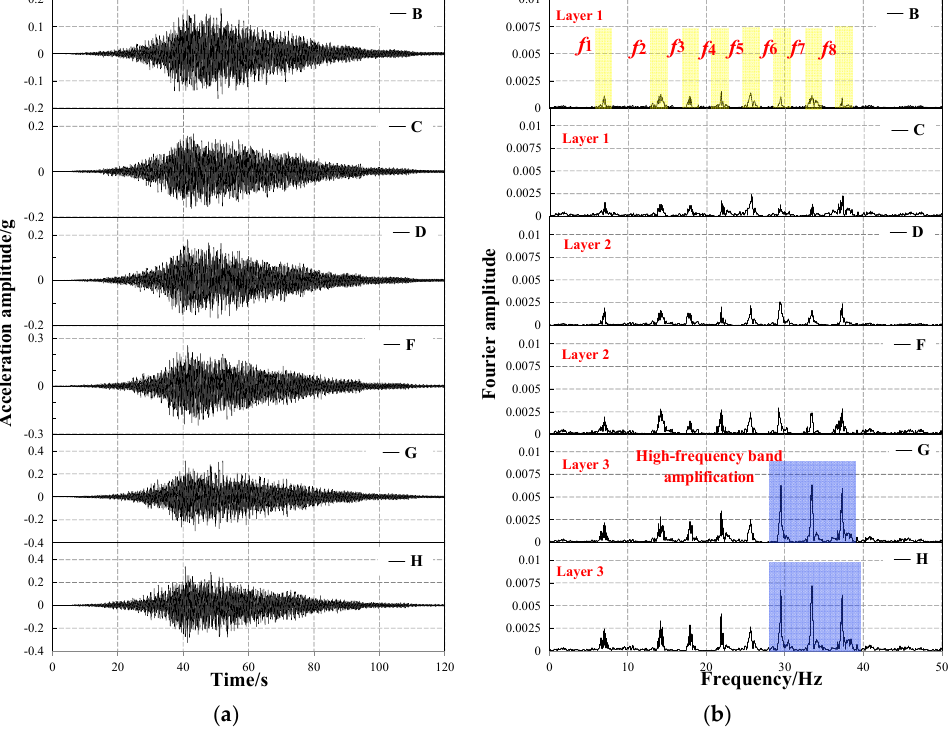
Figure 9. Seismic response of typical points (B, C, D, F, G, and H) at the surface of Model 2 when inputting the WE wave in the x direction: ( a ) acceleration-time history, ( b ) Fourier